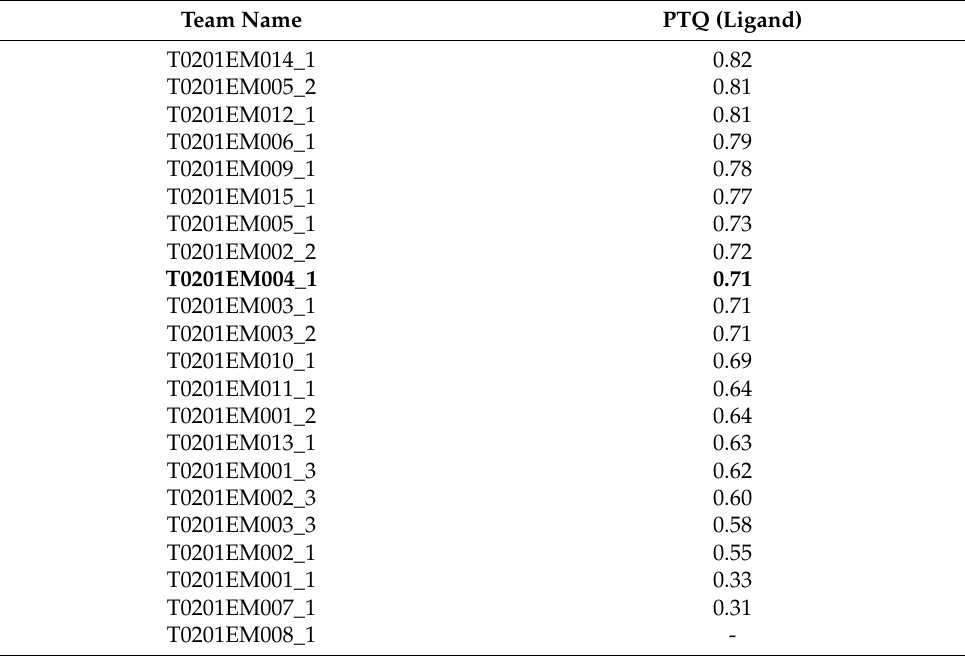
Table 4. Evaluation of Target 201: Escherichia coli beta-galactosidase on Q-score for all the models